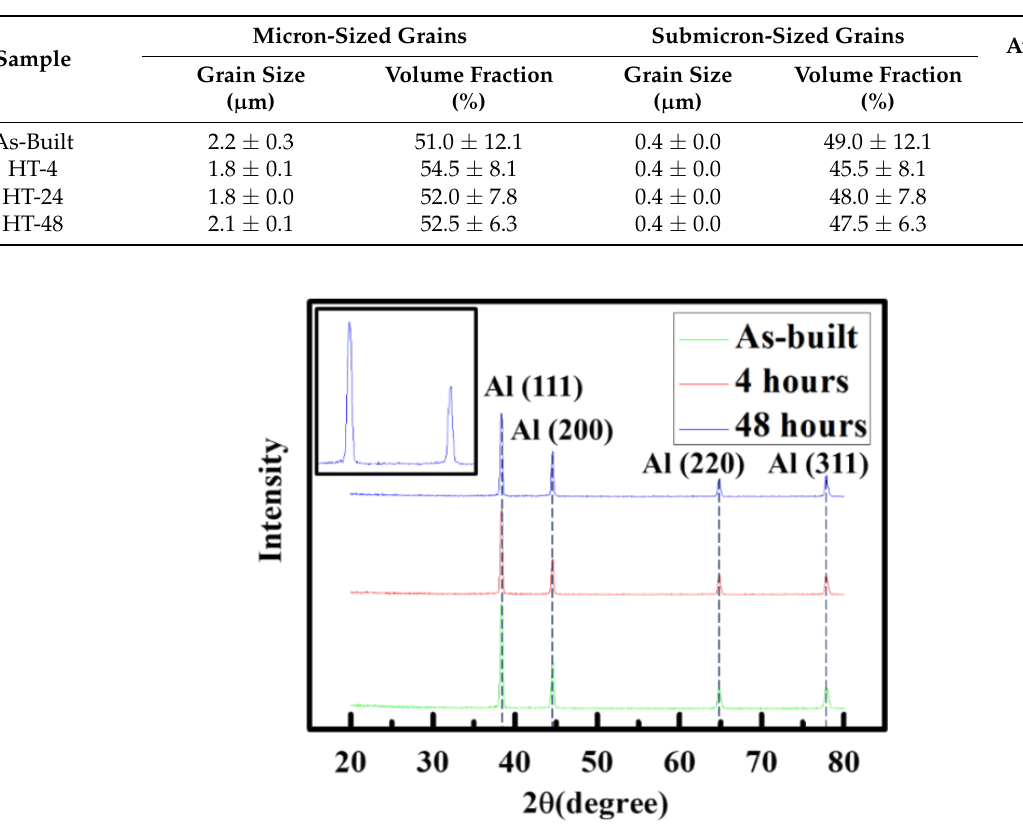
Table 2. The grain size and volume fraction of micron-sized grains and submicron-sized grains of the as-built and heat-treated Scalmalloy samples.